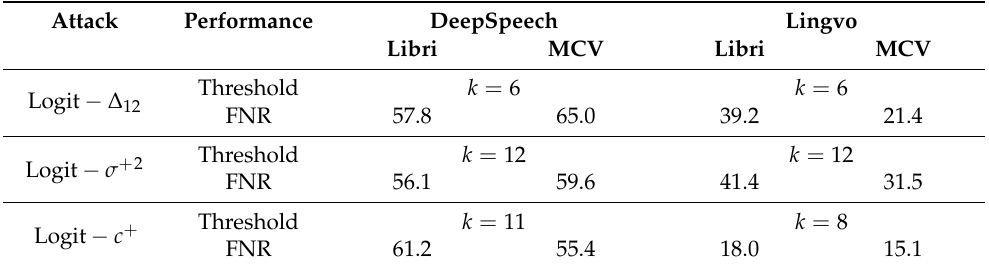
Table 3. Three features detect LT adversarial examples experiment.